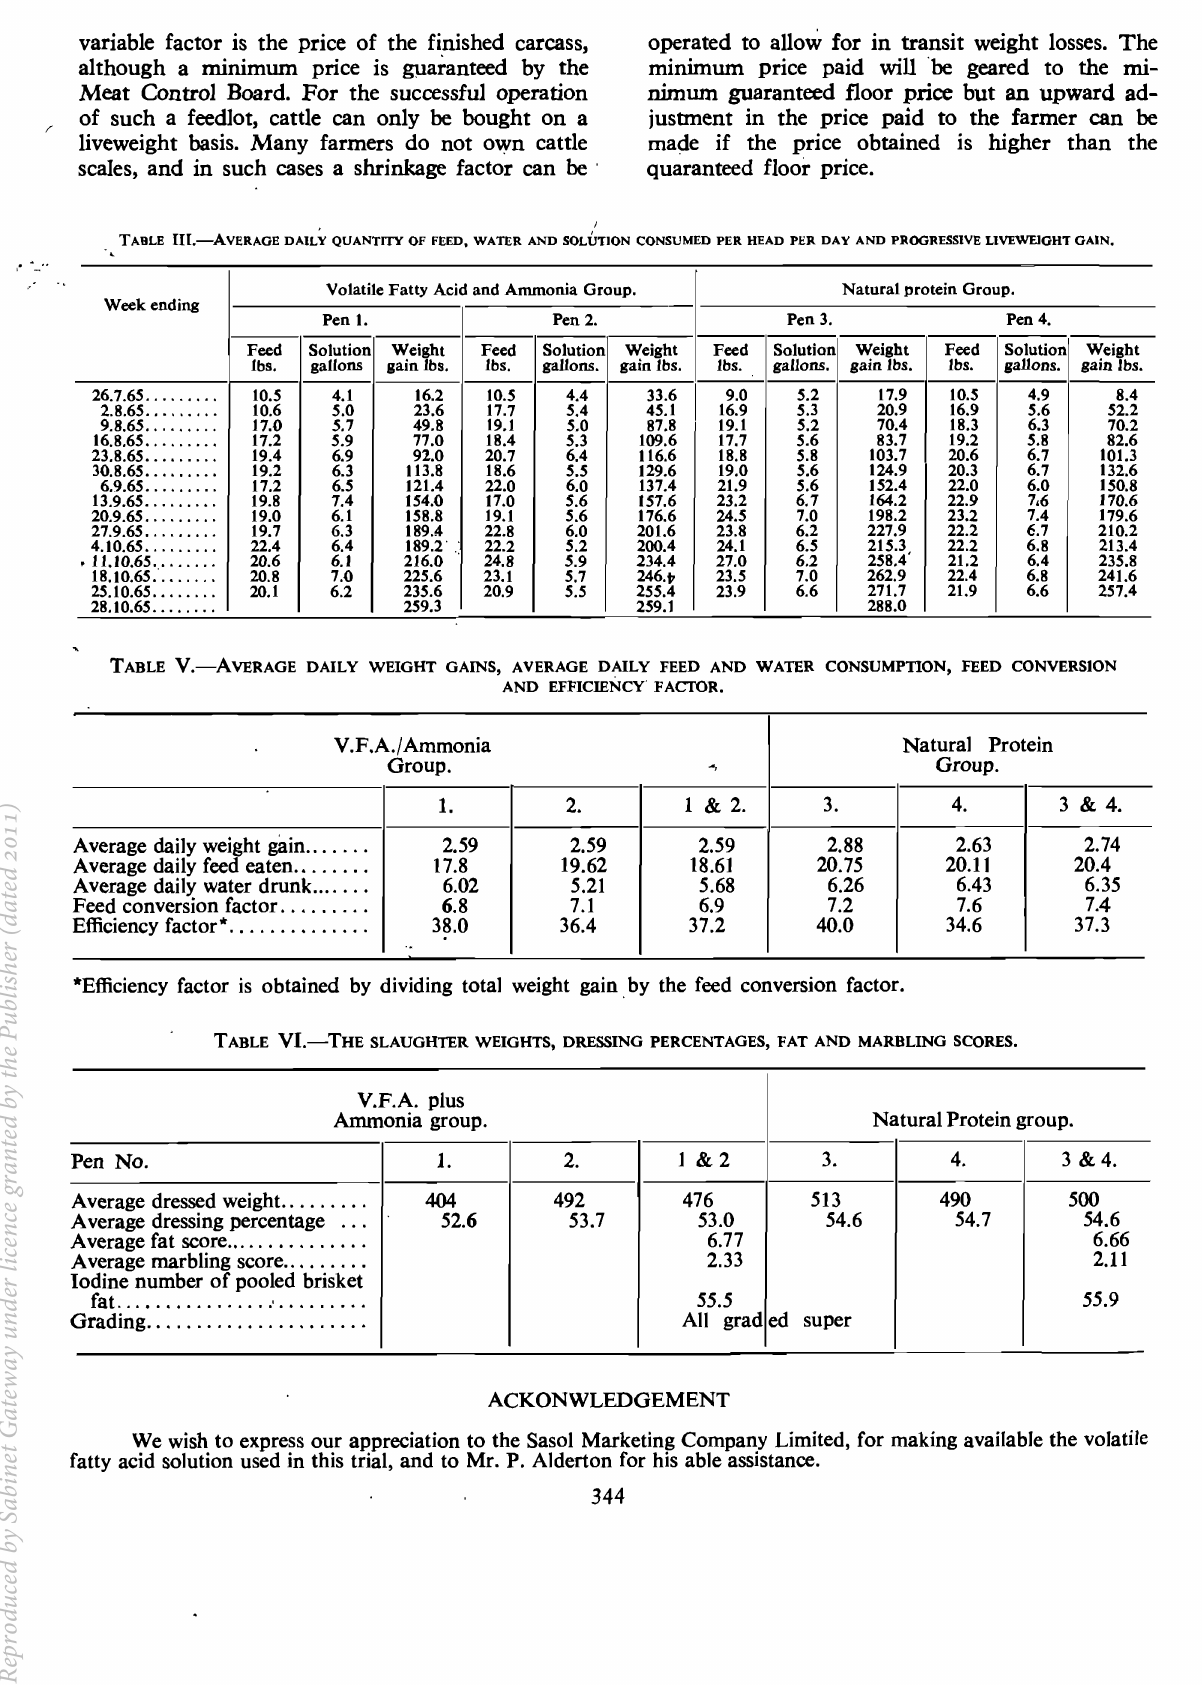
TABLE IlL-AVERAGE DAILY QUANTITY OF FEW, WATER AND SOL~TION CONSUMED PER HEAD PER DAY AND PROGRESSIVE L1VEWEIGHT GAIN. , , Volatile Fatty Acid and Ammonia Group. Natural protein Group. Weekending